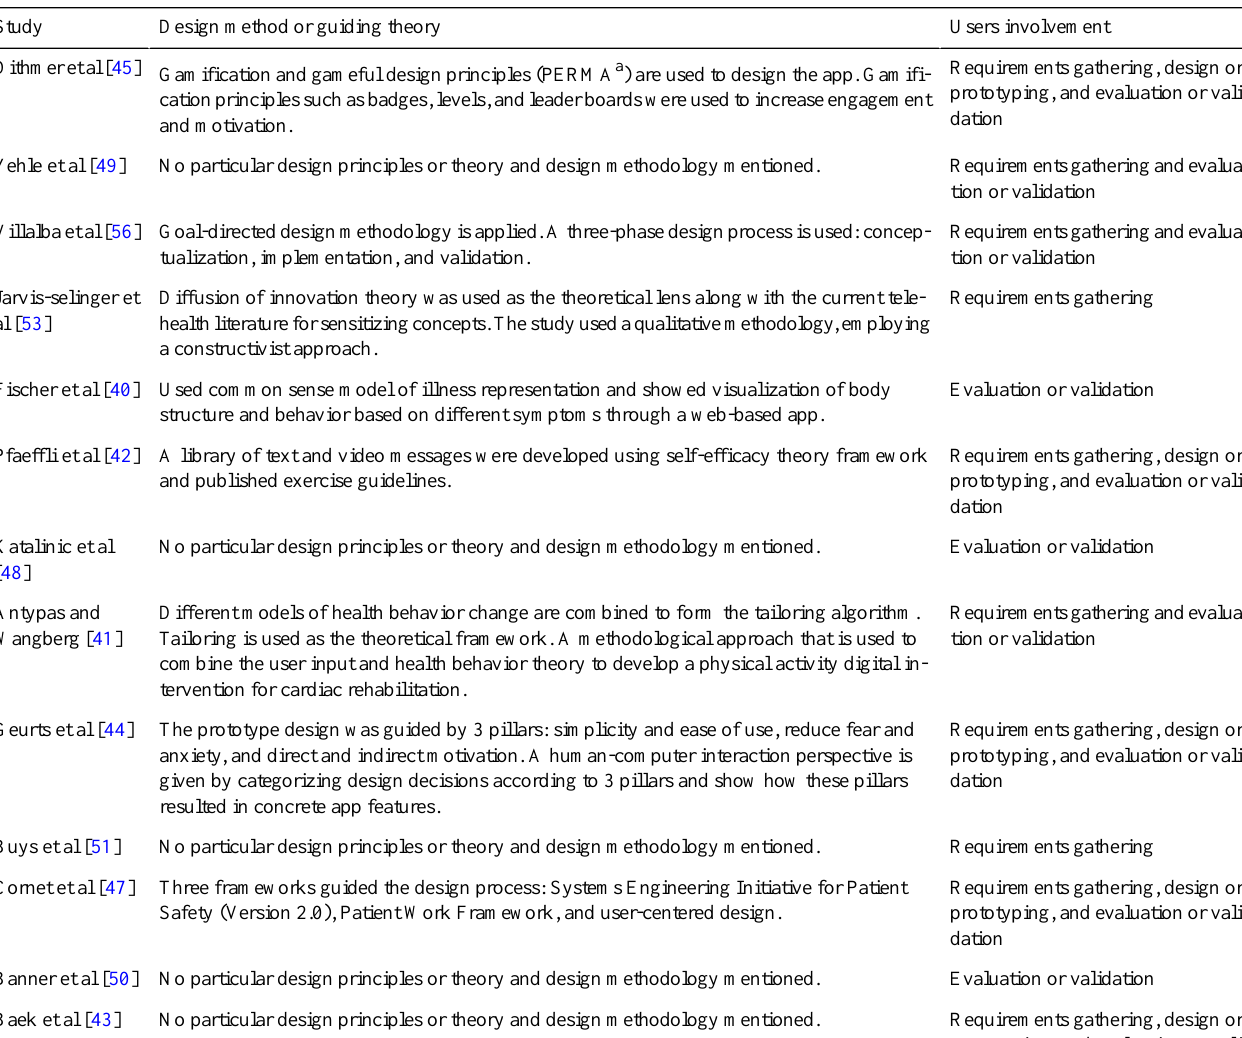
Table 1. Overview of the theories and design approaches used in the final